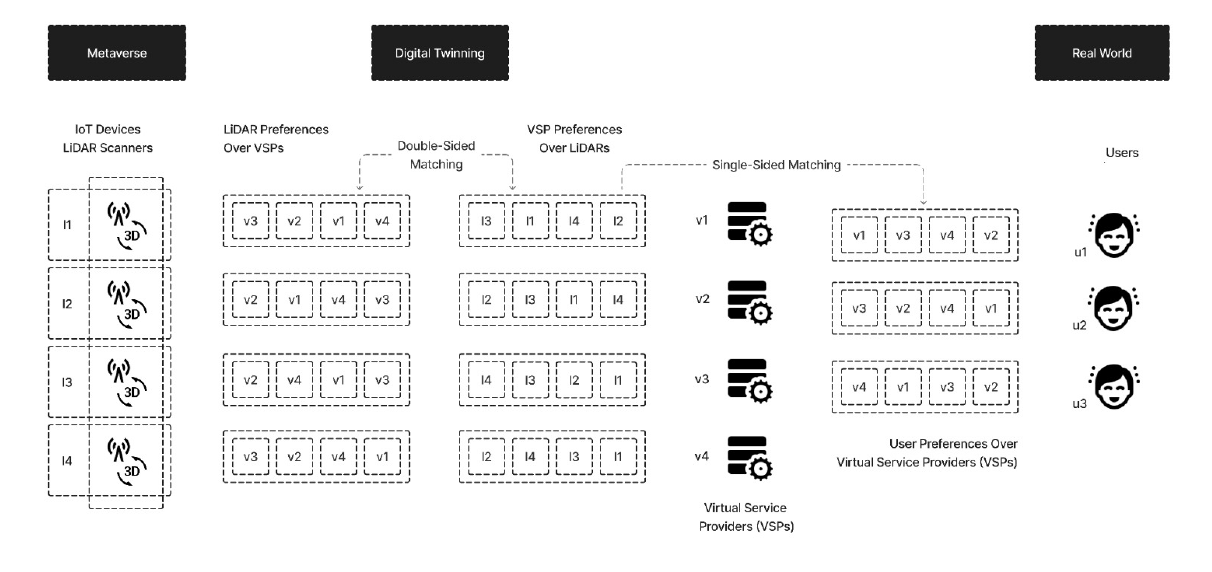
Figure 3. An overview of the proposed